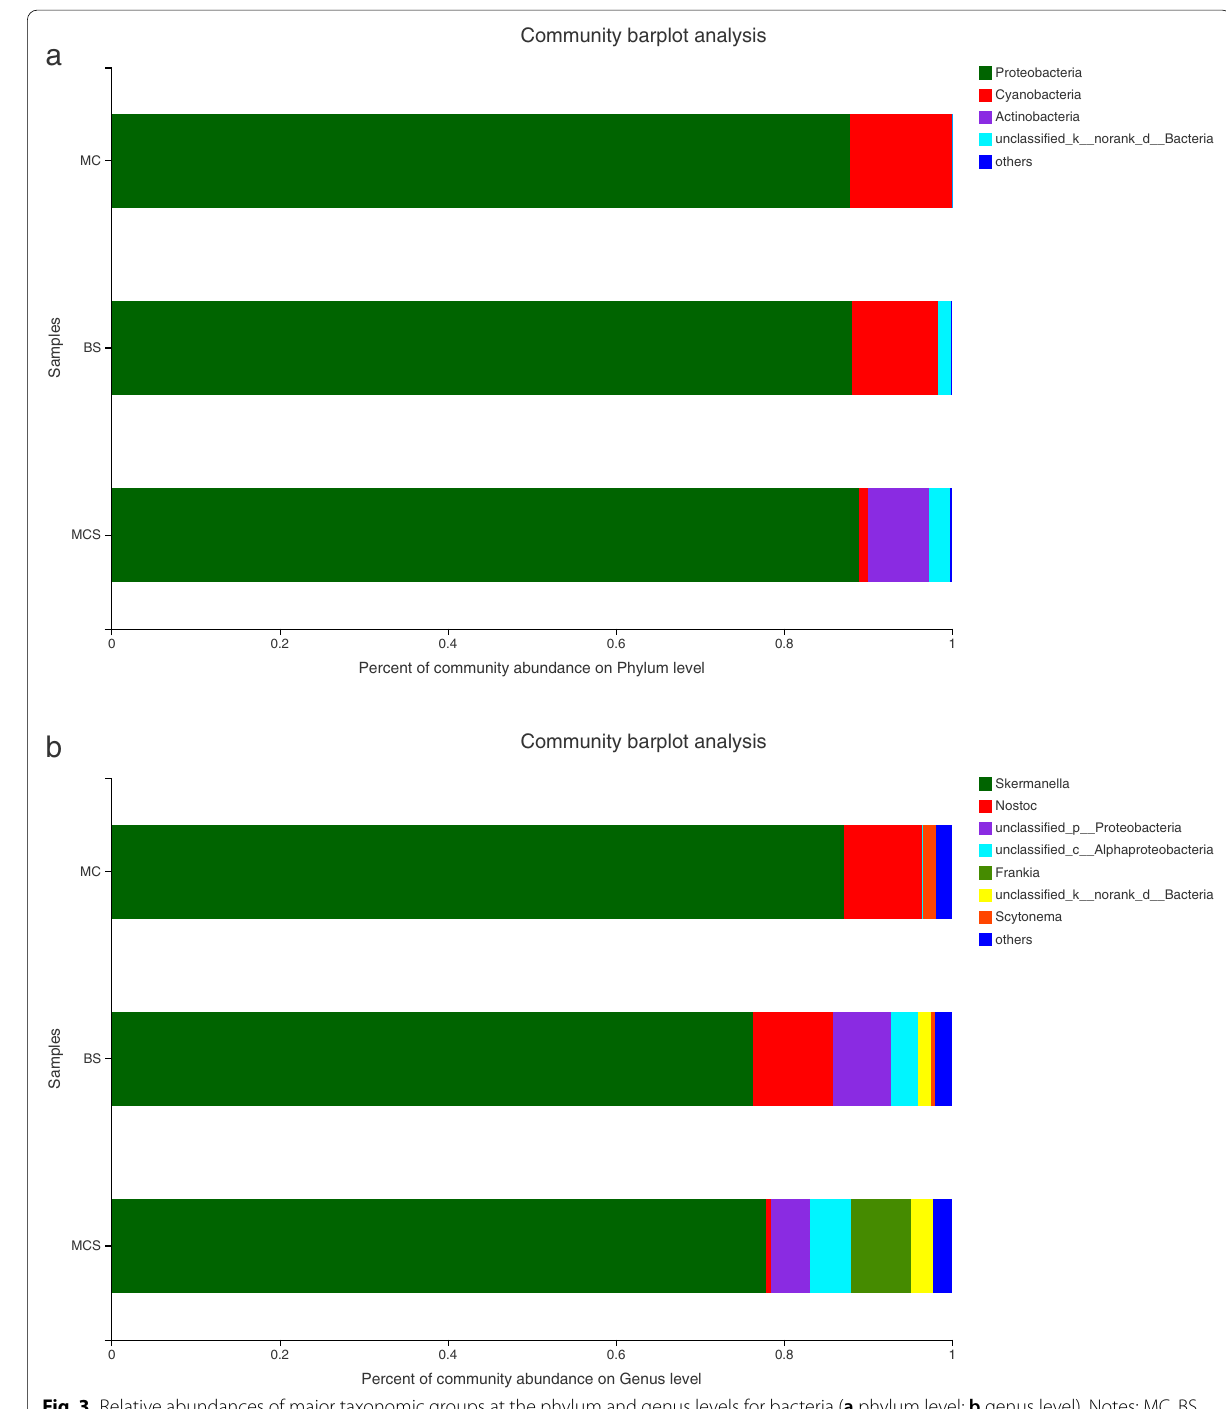
Fig. 3 Relative abundances of major taxonomic groups at the phylum and genus levels for bacteria ( a phylum level; b genus level). Notes: MC, BS, and MCS are the same as in Fig. 1. Columns of different colors represent different species, and the length of the column represents the proportion of the